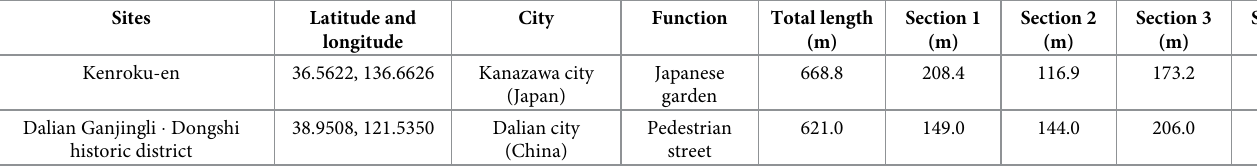
Table 3. Basic information on the two spaces and their data were used for model external validation.